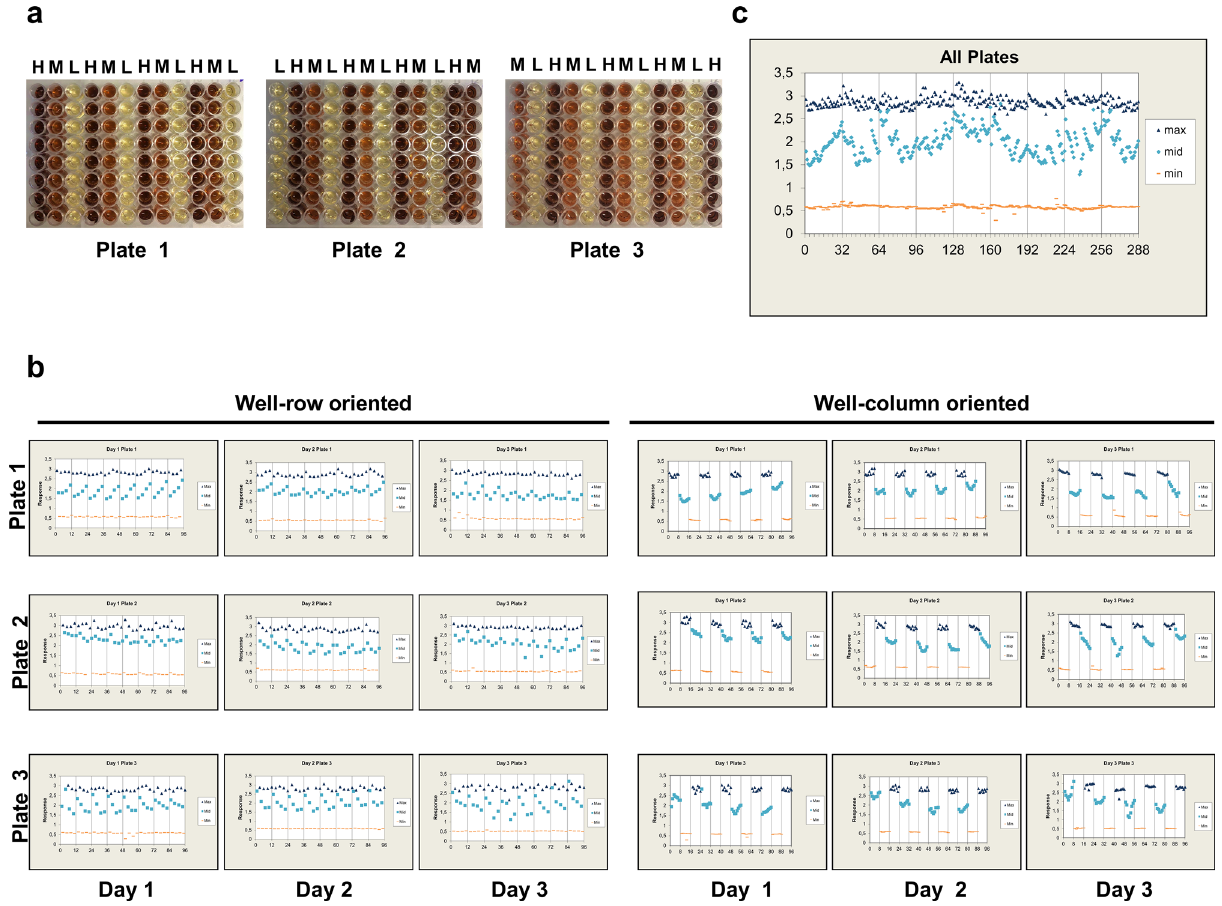
Figure 6. ( a ) To assess the plate uniformity and separation of the signals in our HTS assay at an expression temperature 30 °C; a plate uniformity test was conducted at maximum, medium and minimum signals—0%, 37% and 100% residual HGD activity—in an interleaved signal format to guarantee that the SW is capable of ranking HGD missense variants during screening. All three signals were distributed on each plate but varied systematically so that on all plates, on a given day, each signal is measured on each plate to detect edge or drift effects (3 plates, 3 days). ( b , c ) The obtained signals were also plotted on a scatter plot to reveal patterns of drift or edge effect or other systemic sources of variability. Signals were plotted against well number, first in a column- wise fashion then in a row-wise fashion. Maximum row and column drift for Max signals were 6.47% and 9.62%, respectively. For the Mid signal, we found a significant edge effect as higher signals were observed at the outer columns of the 96-well plate with decreasing intensity moving towards the middle columns of the plate. It is thus recommended to avoid columns 1 and 12 for screening of HGD enzyme variants. Respective Max and Min control signals can still be sampled at these locations. Some calculated drift effects for the Mid signal exceeded the > 20% criteria, but effects were only seen on a single plate or at a few plates and no predominant pattern was observed and can be considered and the data is shown in Table 1. These results were used to perform calculations to provide additional informa- tion on assay parameters to evaluate the overall quality and separation of the assay control data as well as the plate-to-plate and day-to-day variation. First of all, coefficient of variation (CV) of each signal ( i.e. maximum, medium and minimum) were calculated and all CV values should pass the < 20% criteria since HTS assays with CV values < 20% are routinely and successfully employed in screening enzyme variant libraries 45,46 . The maximum signal CV’s were between intervals 1.5–6.3%, midpoint signal CV’s were between intervals 3.1–16.6% and minimum signal CV’s were between intervals 1.3–2.3%. Consequently, all CV values pass the < 20% criteria if 10 repeats per equivalent signal were considered. Average plate Z’ values and SW values (Eqs. 2 and 3) were 0.88 ± 0.06 and 31.51 ± 15.67, respectively. Moreover, both parameters pass the minimum acceptance criterion for Z’ values > 0.4 and SW values > 2. However, normalized mid signal (mid %) standard deviations (SD’s) below 20% and within-day fold shifts as well as average between day fold shifts < 2 acceptance criteria were not fulfilled. This indicates that assay robustness cannot be guaranteed under the previously described conditions, possibly due to the fact that the auto-oxidation and self-polymerization process of HGA into pyomelanin was not com- plete in the 96-well plate at 22 °C. In analogy, assay robustness was also evaluated for expression temperature 30 °C and the data is shown in Table 2. The maximum signal CV’s were between intervals 1.8–3.3%, midpoint signal CV’s were between intervals 5.6–15.8% and minimum signal CV’s were between intervals 1.3–5.2%. Con-